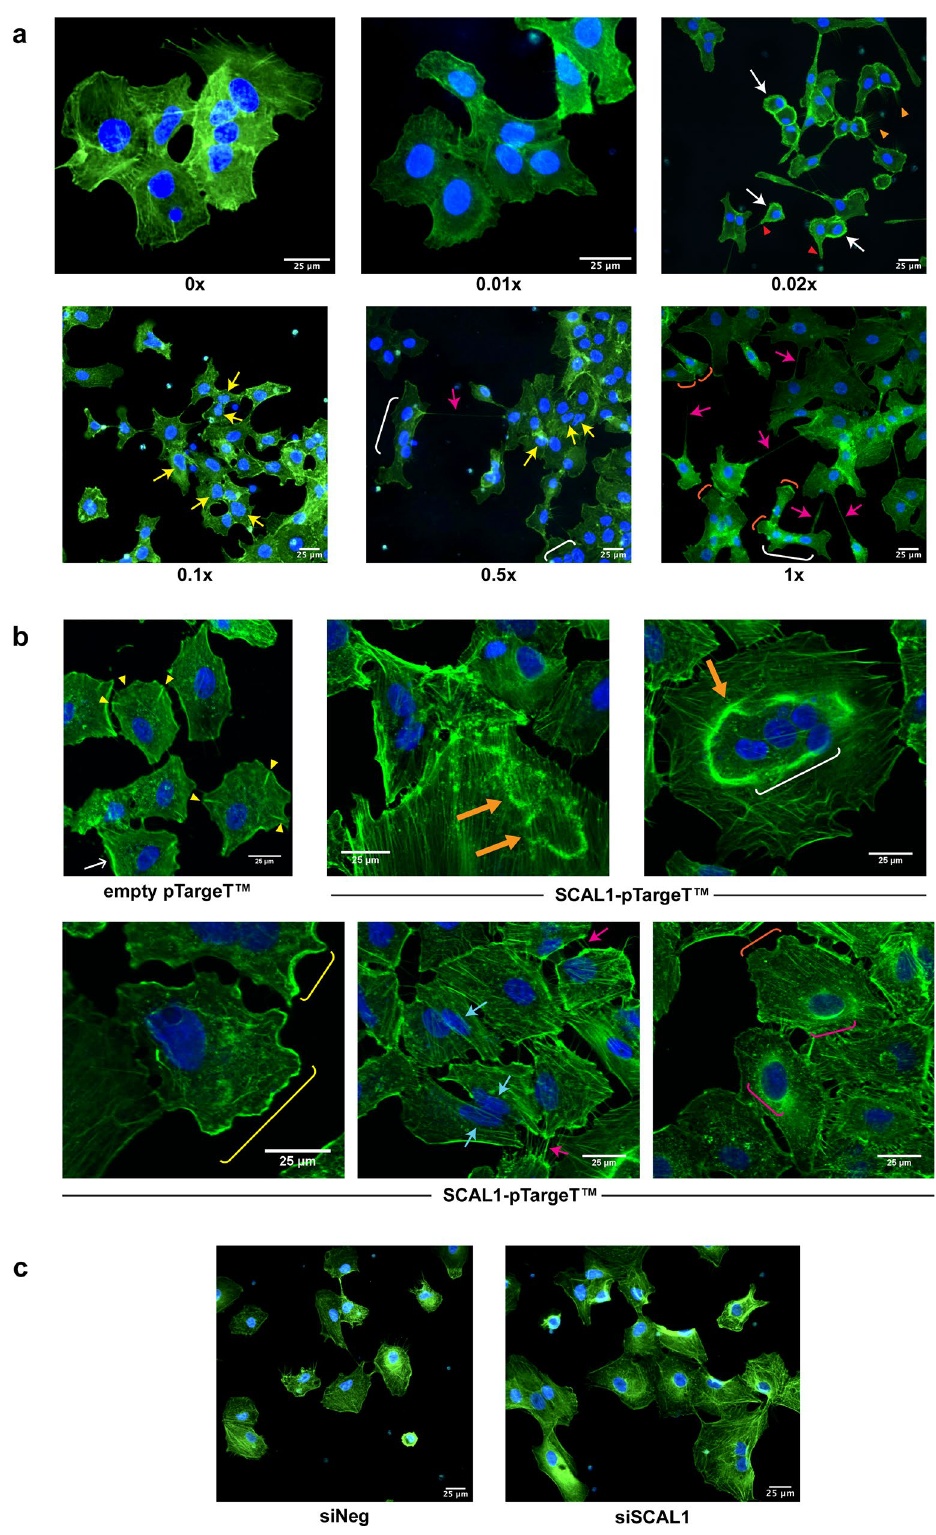
Figure 3. Fluorescent staining of CSE-treated, SCAL1-overexpressing and SCAL1-deficient A549 cells with Phalloidin-FITC and Hoechst 33342 (Olympus IX3-HOS, ×400, FITC: 500 ms). ( a ) A549 cells exposed to different CSE dilutions showed formation of structures associated with migration and invasion such as invadopodia (red arrowheads), hair-like filopodia (orange arrowheads), thick peripheral actin (white arrows), tunneling nanotube (TNT)-like structures (fuchsia arrows), multilobulated nuclei (yellow arrows), multinucleated cells (white brackets), and lamellipodia (orange brackets). ( b ) Empty vector-transfected control cells showed a stable cytoskeleton with prominent radial protrusions/focal adhesions (yellow arrowheads). Cells transfected with SCAL1 displayed transient structures such as circular dorsal ruffles (thick yellow orange arrows), peripheral dorsal ruffles (yellow brackets), stretched nuclei (cyan arrows) and perinuclear actin rims (fuchsia brackets). ( c ) A549 cells transfected with SCAL1-siRNA were more detached from one another and exhibited a more organized cytoskeleton with prominent stress fibers compared to siNeg